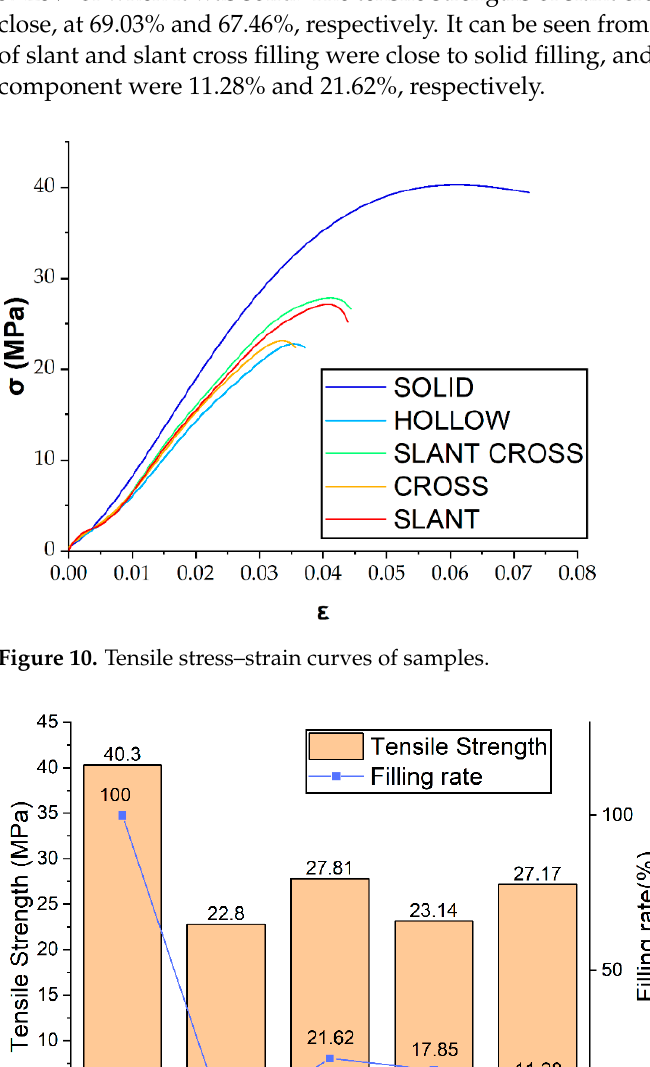
Figure 9. Tensile test of the test sample. ( a ) Tensile test; ( b ) unused sample; ( c ) used sample.